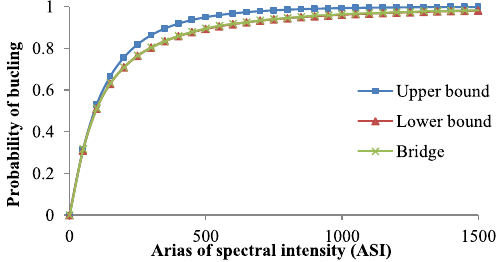
Figure 7. Probability of Exceeding/ASI.